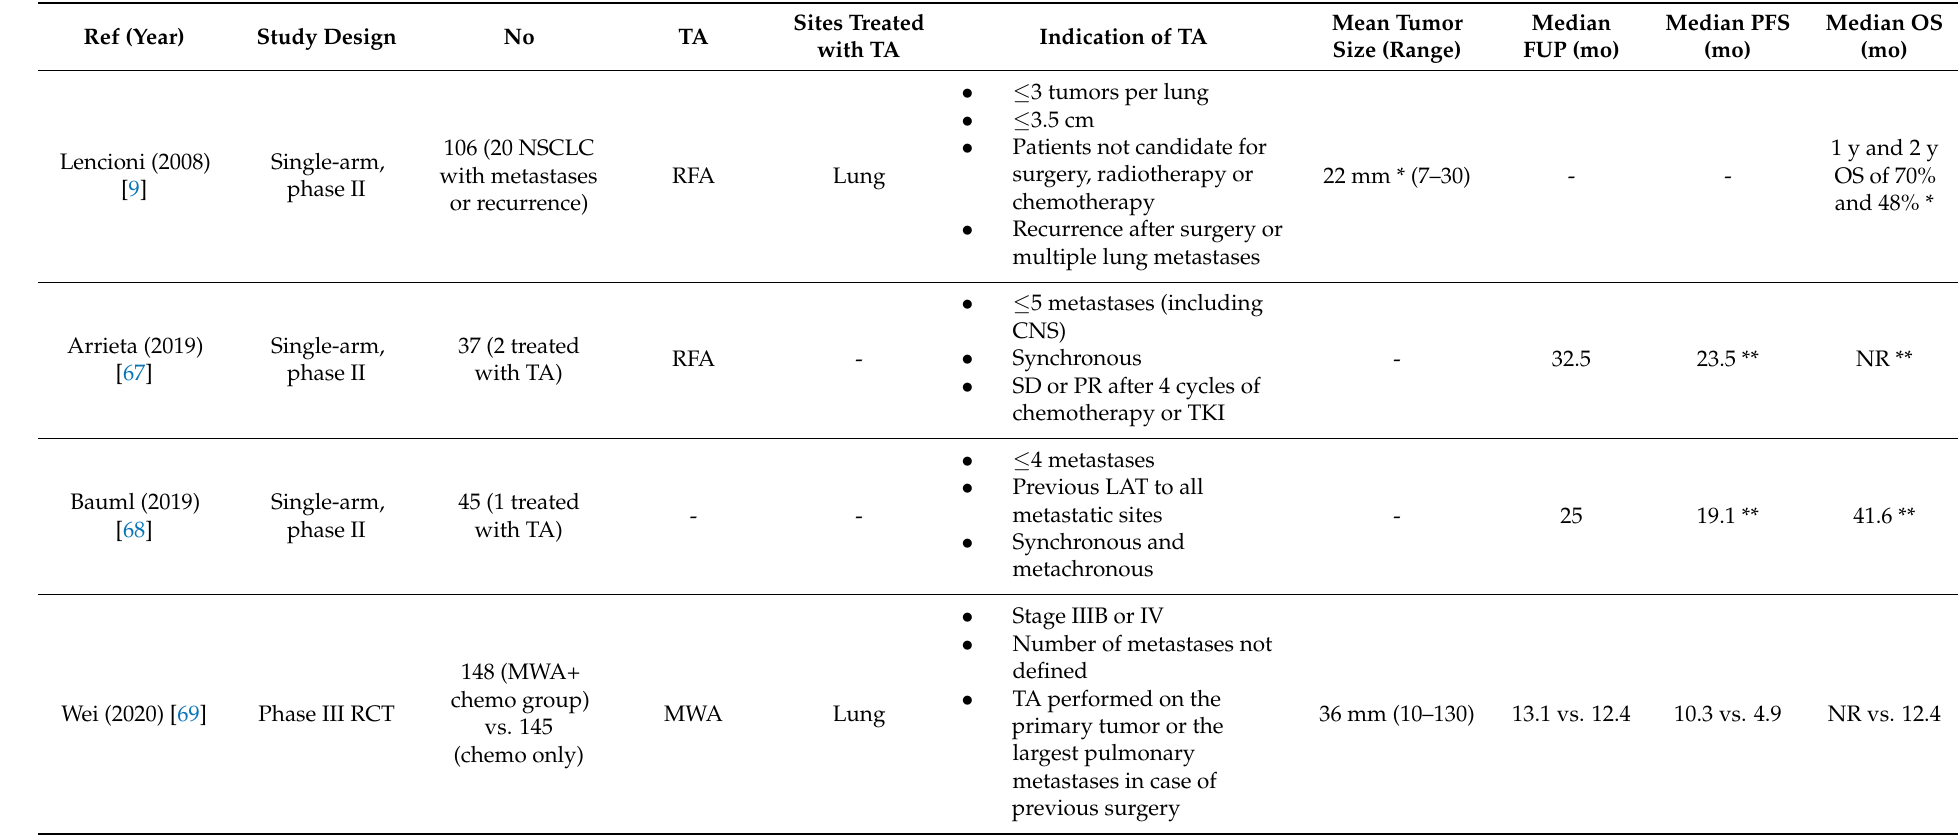
Table 1. Selected prospective studies evaluating thermal ablation for oligometastatic NSCLC